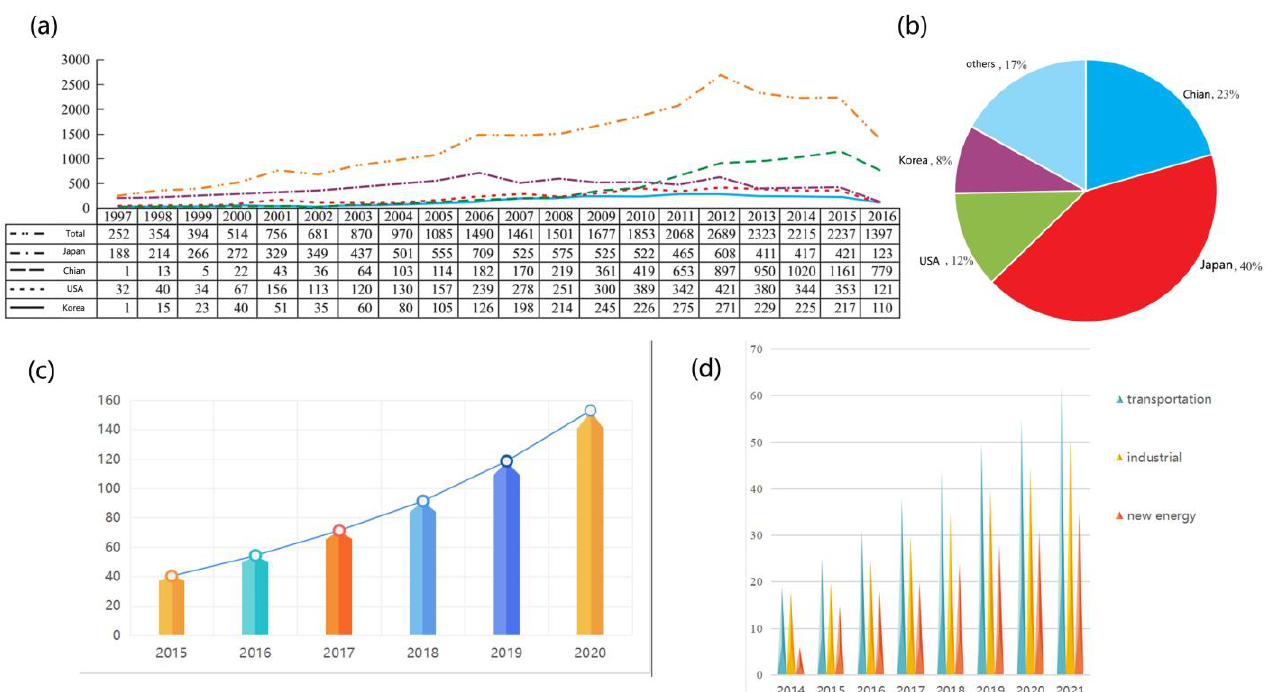
Figure 9. ( a ) Patent application trend in the field of supercapacitors. ( b ) Distribution of patent application country (region). ( c ) China supercapacitors market size forecast (CNY 100 million). ( d ) Subdivision product scale and forecast of supercapacitor in China.